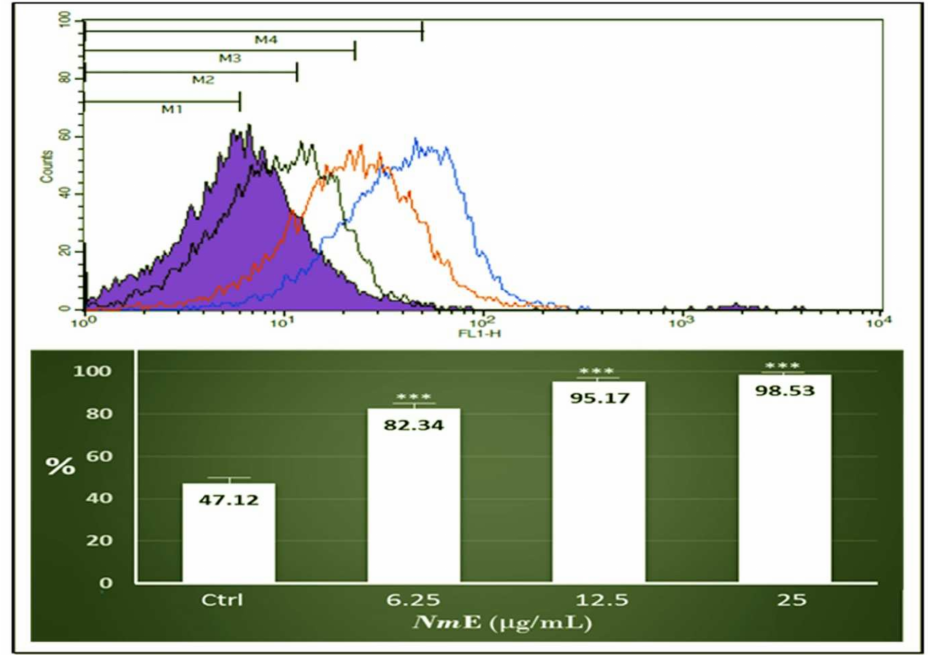
Figure 12. Effects of Nm E on ROS production in HepG2 cancer cells. The maximum effect occurred at 48 h post-treatment. Bars represent the means ± SD. *** p < 0.001 vs. control (DMSO-treated) cells.